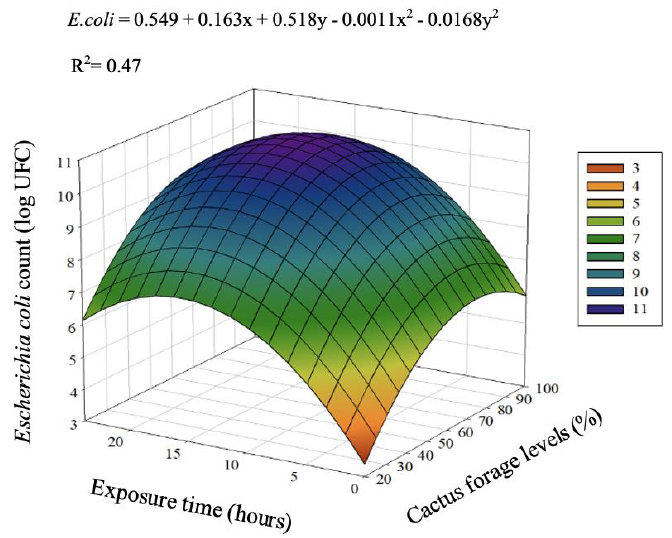
Figure 3. Escherichia coli population as a function of cactus forage levels and time of exposure to